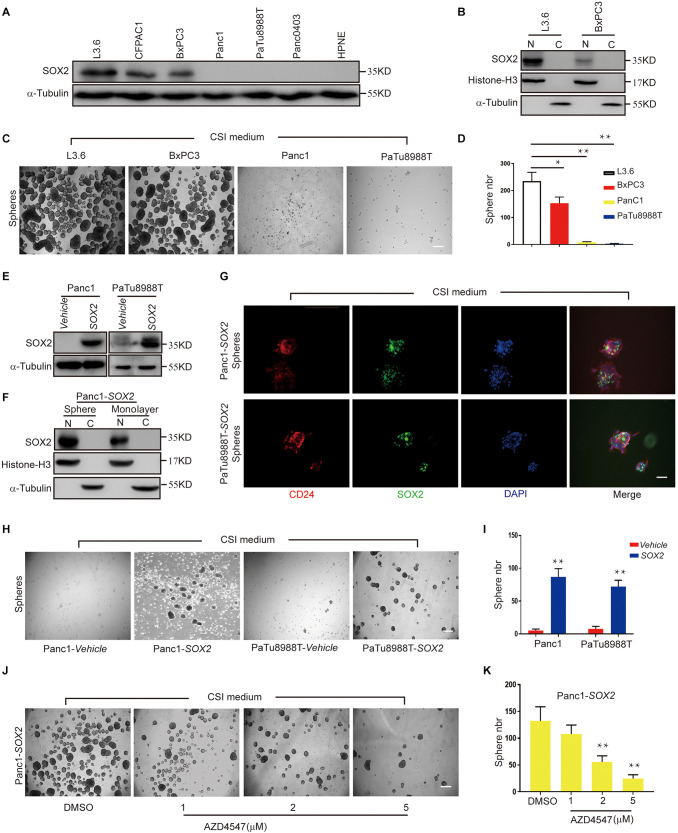
SOX2 overexpression in SOX2 negative PDAC lines leads to increased spheroid formation. (A) Western blot for SOX2 showing SOX2-positive and SOX2-negative pancreatic cell lines. Alpha-Tubulin is used as a loading control. (B) SOX2 detection in cytoplasm and nucleus protein fractions. Histone-H3 and alpha-Tubulin are used as compartment specific loading controls. (C) Sphere formation assay using SOX2-positive and SOX2-negative PDAC lines. (D) Corresponding sphere number quantification for three independent experiments, *p ≤ 0.05, **p ≤ 0.01. (E) Validation by western blot of that SOX2 overexpression has been achieved in the two pancreatic cancer cell lines with low/negative endogenous SOX2 expression. (F) Expression of SOX2 in monolayer and spheroid Panc1-SOX2 cells, separated into the nuclear and cytoplasmic fractions. (G) Validation of SOX2 overexpression and localization in the two PDAC lines by immunofluorescence. Spheroids were stained with SOX2 and CD24 specific antibodies, respectively, and counterstained with DAPI. Scale bar: 100 μm. (H) Sphere formation of previous SOX2-negative cells (Panc1 and PaTu8988T) transfected with either vehicle plasmid (control) or SOX2-plasmid (experimental). Note that SOX2 overexpression is sufficient to increase sphere formation. (I) Corresponding sphere number quantification for three independent experiments. (J) Impact of AZD4547 treatment on SOX2-overexpressing Panc1 cell ability to form spheres. (K) Corresponding sphere number quantification for three independent experiments. Scale bar for (C,H,J): 200 μm, scale bar for (H): 100 μm.